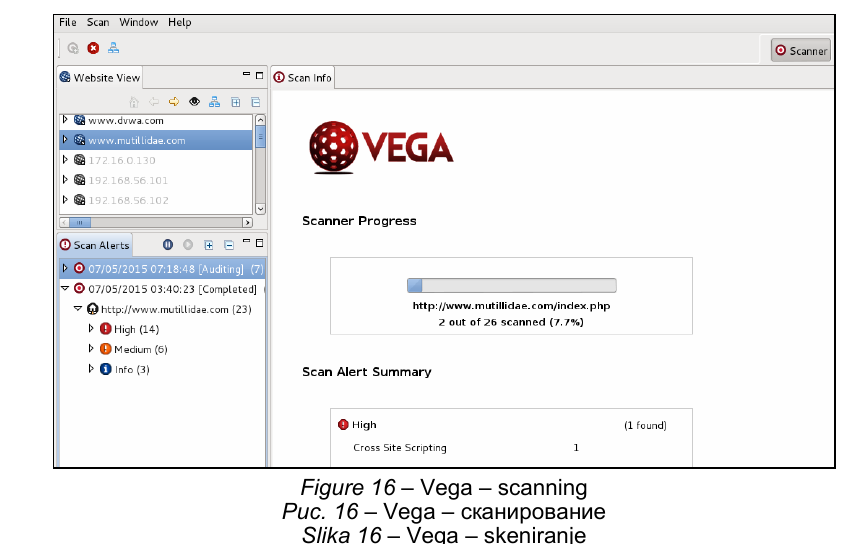
Figure 16 – Vega – scanning Рис . 16 – Vega – сканирование